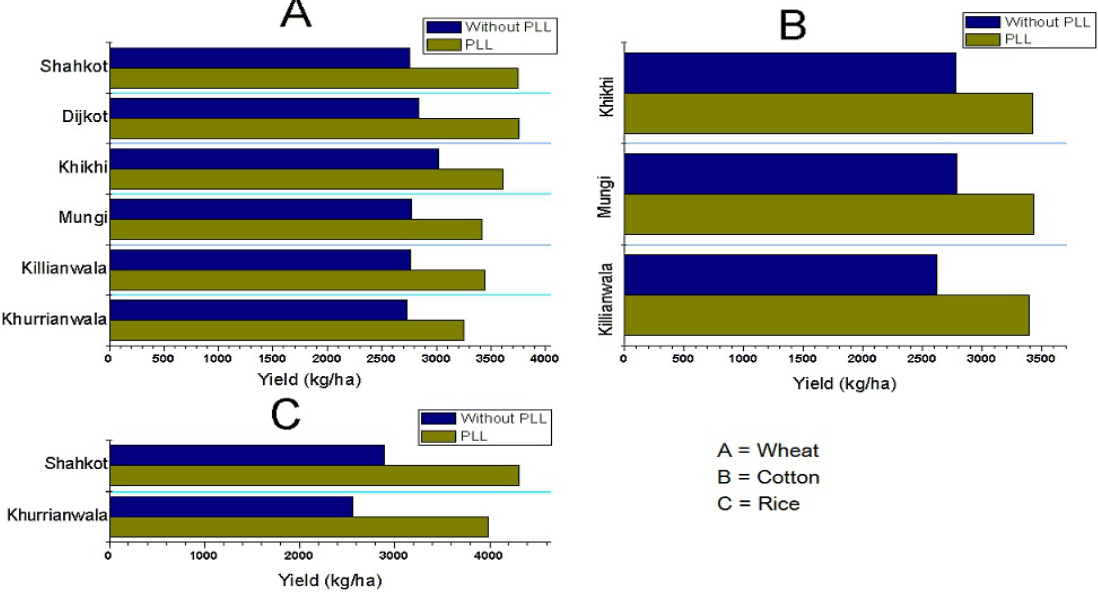
Figure 7. Yield comparison of wheat, cotton and rice with and without PLL.